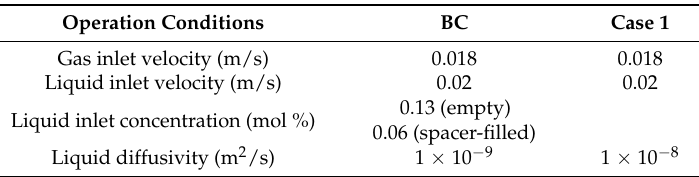
Table 1. Simulated cases for parallel-flow HASMC.